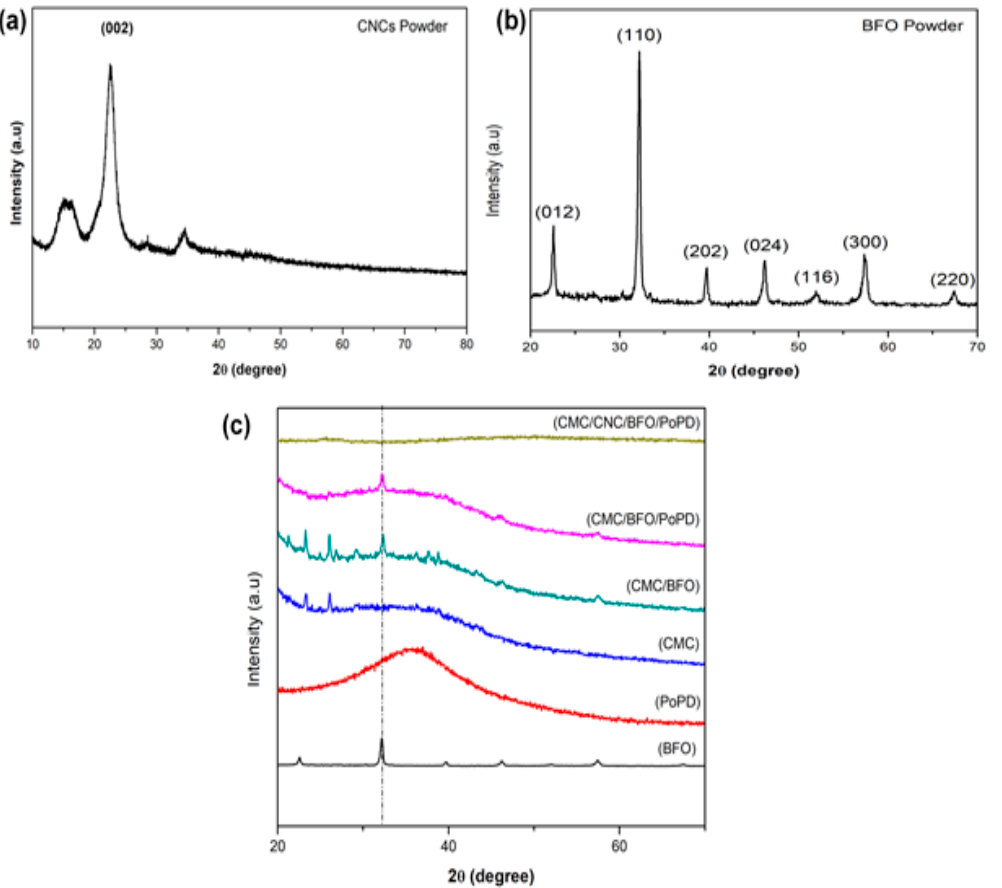
Figure 1. XRD diffractogram of ( a ) CNCs powder, ( b ) BFO powder, ( c ) PoPD powder, CMC film, CMC/BFO, CMC/BFO/PoPD, and CMC/CNC MCC /BFO/PoPD.